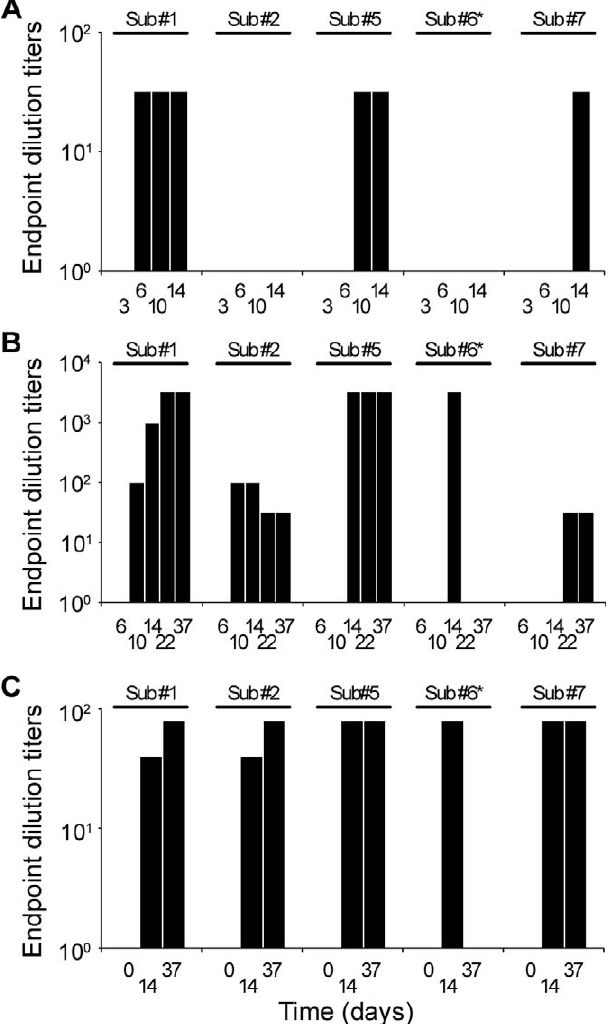
Figure 3. Serological Response Profile for Rhesus Monkeys Given Post- Exposure Treatment for ZEBOV Infection IgM (A), IgG (B), and development of EBOV-neutralizing antibodies (C) in sera of animals treated with 2 3 10 7 pfu of VSV D G/ZEBOVGP 20–30 min after i.m. challenge with 1,000 pfu of ZEBOV.